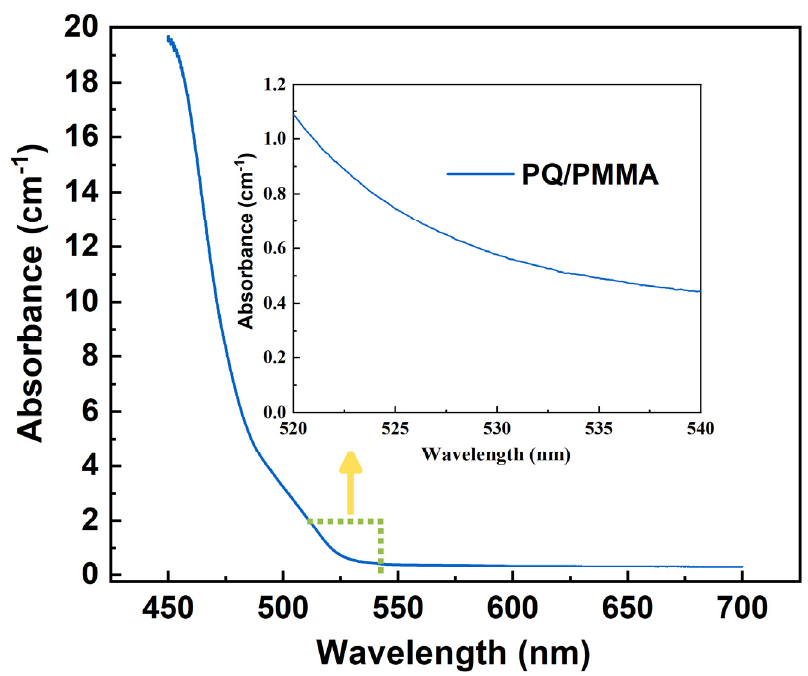
Figure 13. UV-vis absorption spectrum of 1.5 mm PQ/PMMA.